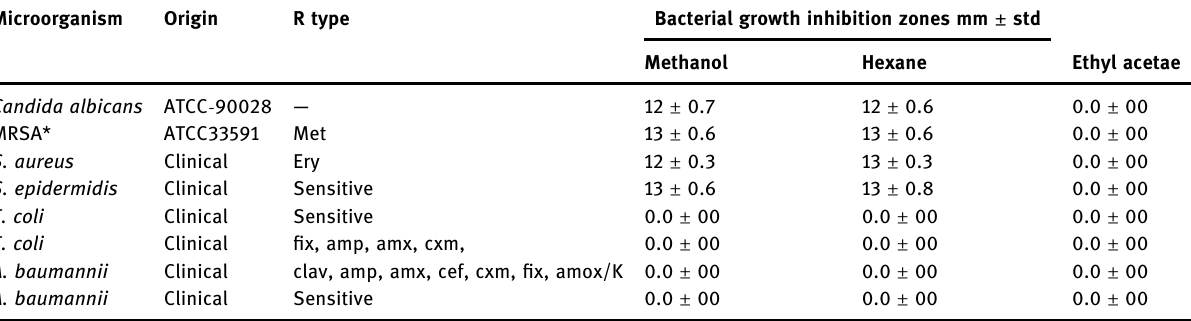
Table 1: Suppression of microbial growth by hexane and methanol propolis extracts as measured by zone of inhibition diameter